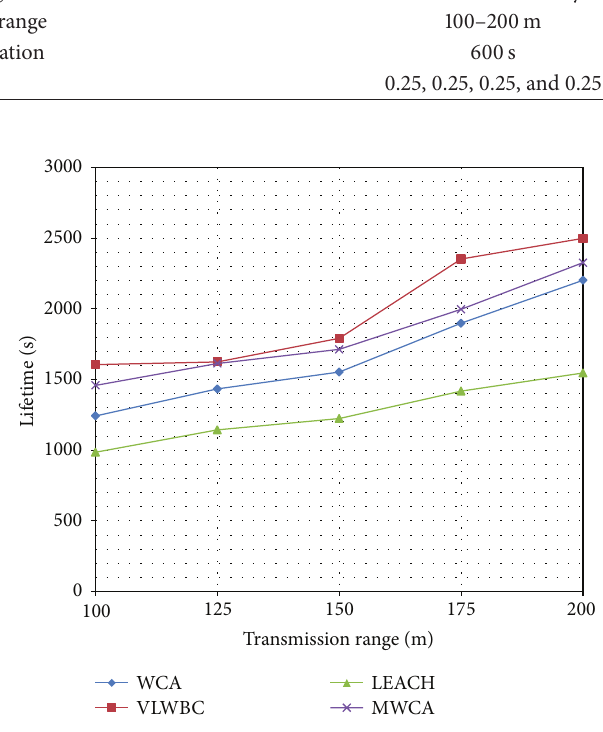
Figure 4: Lifetime factor as the nodes’ transmission range